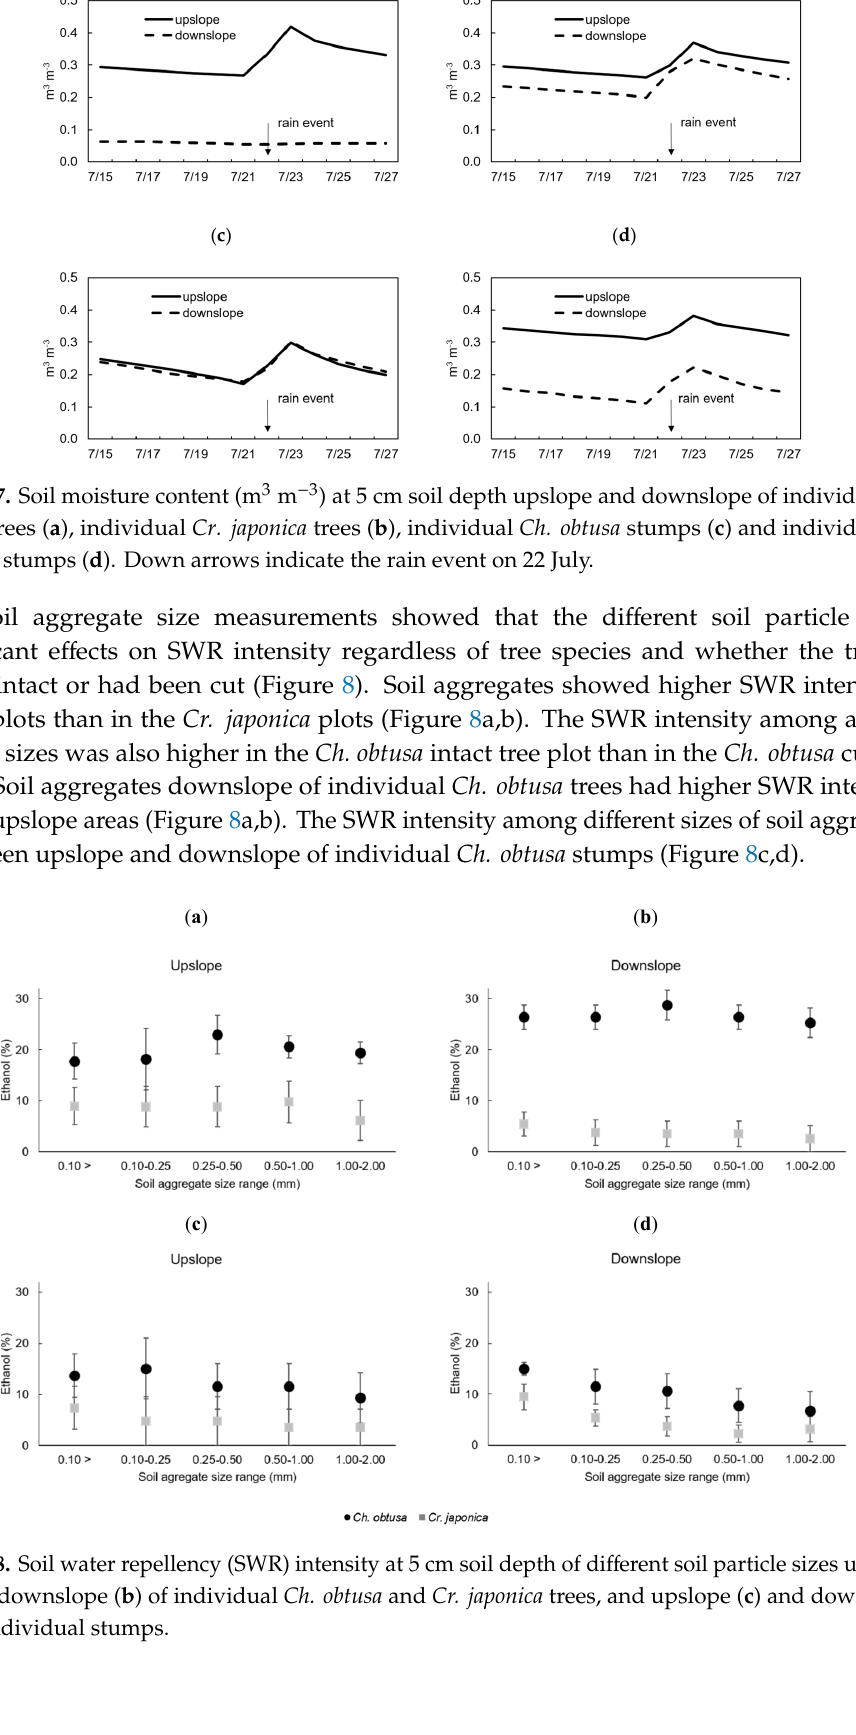
Figure 8. Soil water repellency (SWR) intensity at 5 cm soil depth of different soil particle sizes upslope ( a ) and downslope ( b ) of individual Ch. obtusa and Cr. japonica trees, and upslope ( c ) and downslope ( d ) of individual stumps.